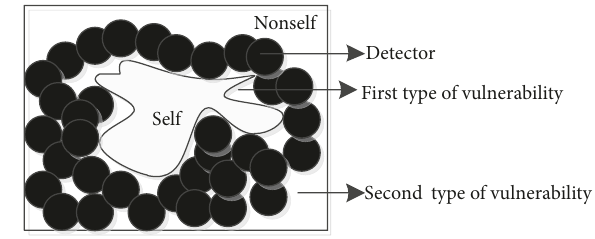
Figure 1: Two kinds of